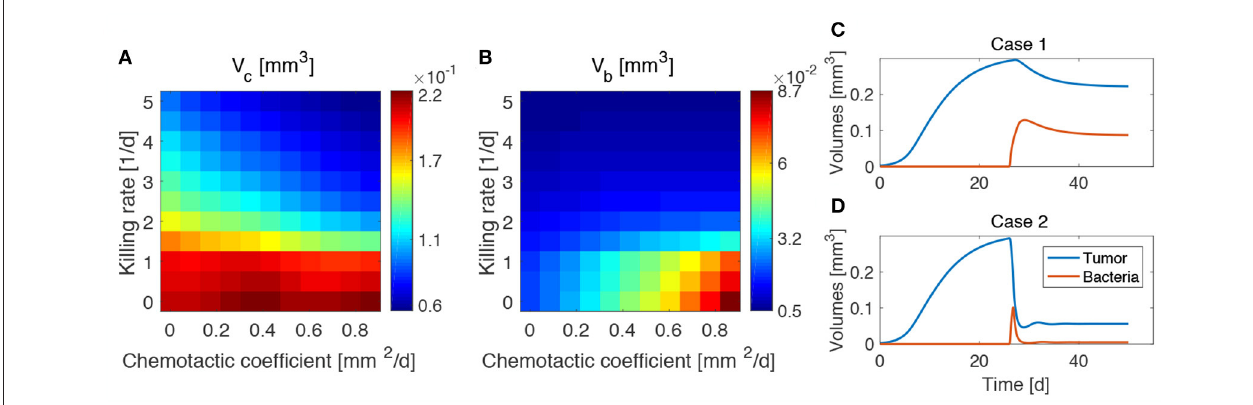
FIGURE 4 | Influence of bacteria chemotactic coefficient and anti-tumor activity on tumor (A) and bacteria (B) volumes at the end of the simulations (day 50). Temporal evolution of tumor and bacteria volumes for a high chemotactic coefficient and a low (Case 1, C ) and high (Case 2, D ) killing